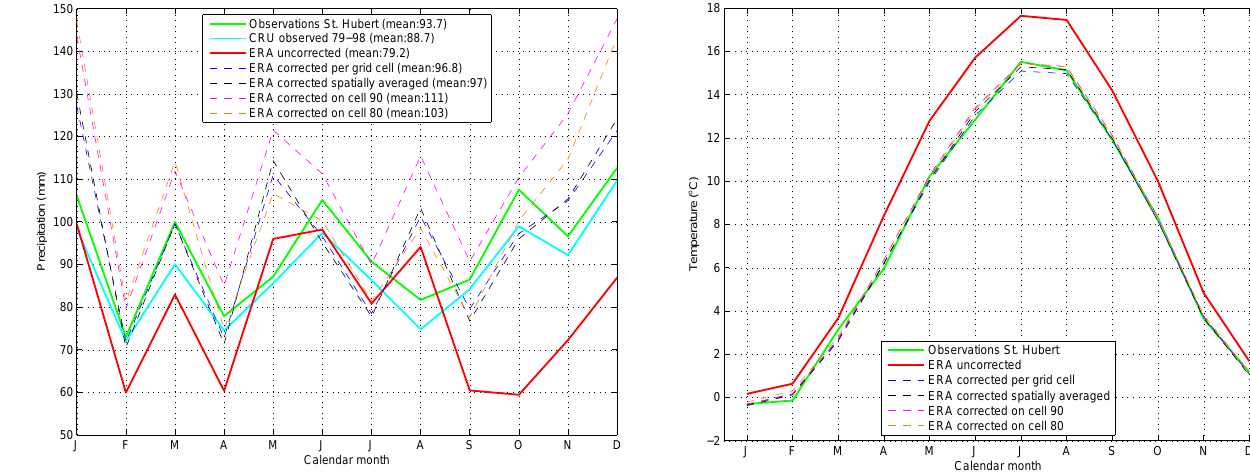
and σ (T obs ) are the mean and standard deviation of the ob- served daily temperature for the considered five-day period.